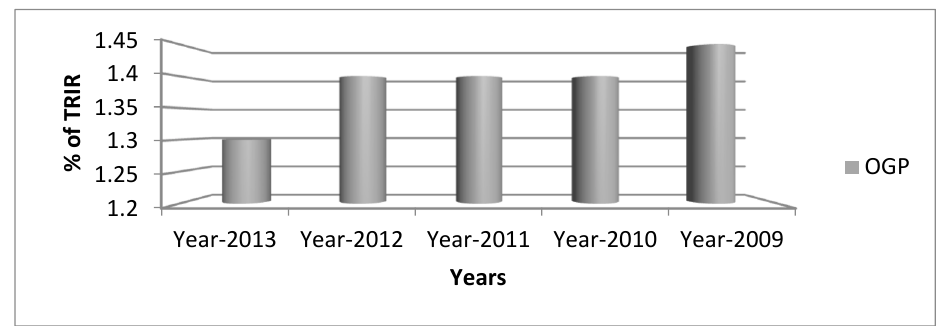
Figure 1. TRIR Analysis indicators in safety field